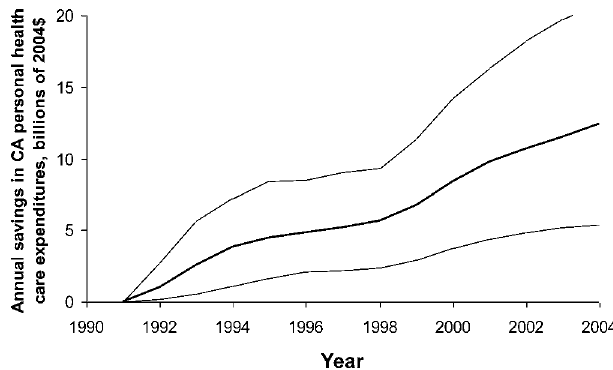
Figure 3. Savings in Personal Health Care Expenditures The estimated annual personal health care expenditures savings associated with the CTCP began to appear shortly after the program began and grew over time. (Lighter lines indicate the 95% CI for the annual